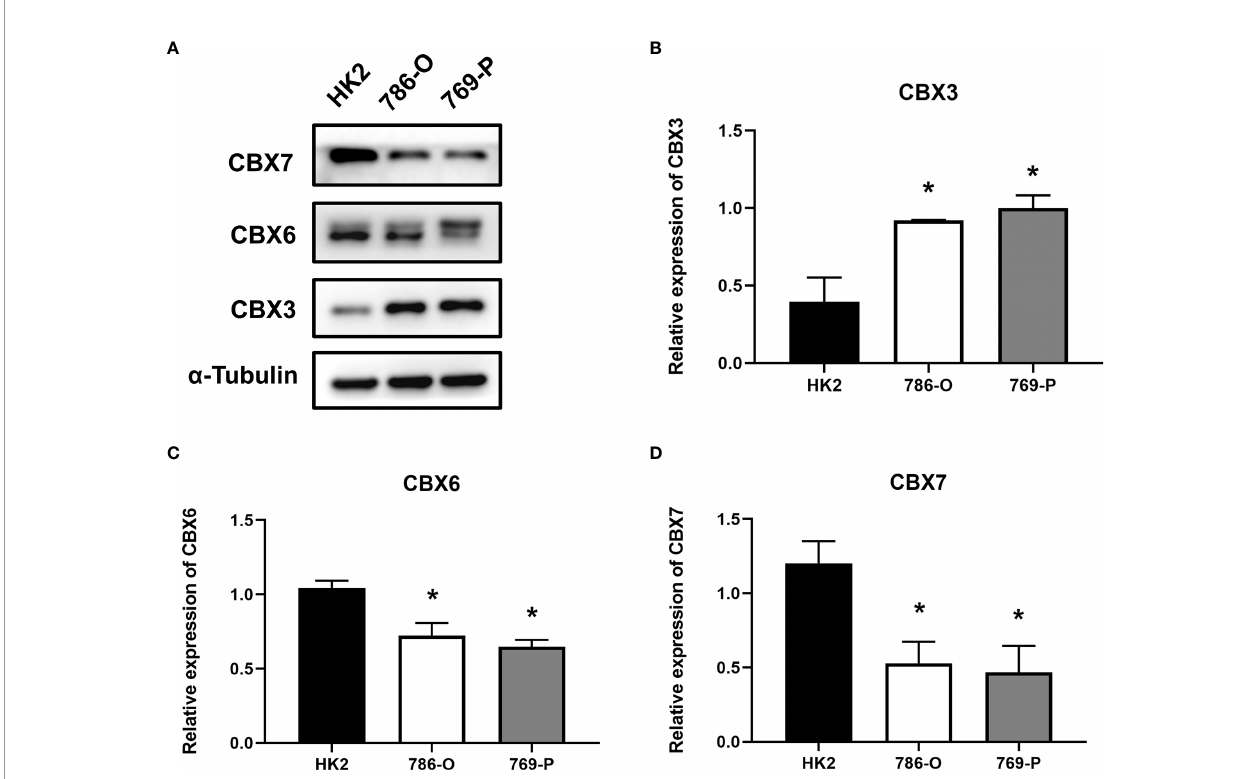
FIGURE 3 | The protein expression levels of CBX3, CBX6 and CBX7 in normal kidney cell and ccRCC cells (Western blotting). CBX3 protein was much higher in ccRCC cell lines than that in HK2 cells, while CBX6 and CBX7 were signi fi cantly reduced in ccRCC cells. The representative western blotting image of CBX3, CBX6 and CBX7 in ccRCC cells and normal kidney cells (A) . The statistical results of western blotting of CBX3, CBX6 and CBX7 in ccRCC cells and normal kidney cells (B – D) . (* P